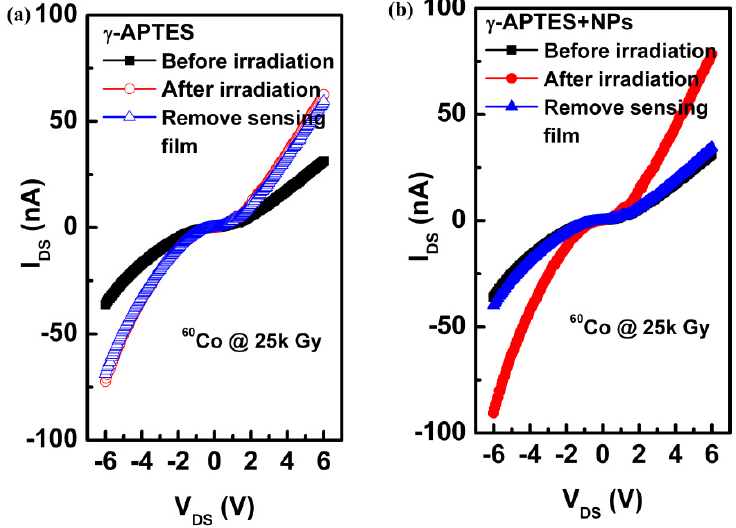
as a function of drain-to-source voltage V Figure 4. Channel current I DS after γ -ray sterilization, and the removal of the post-irradiated sensing films for